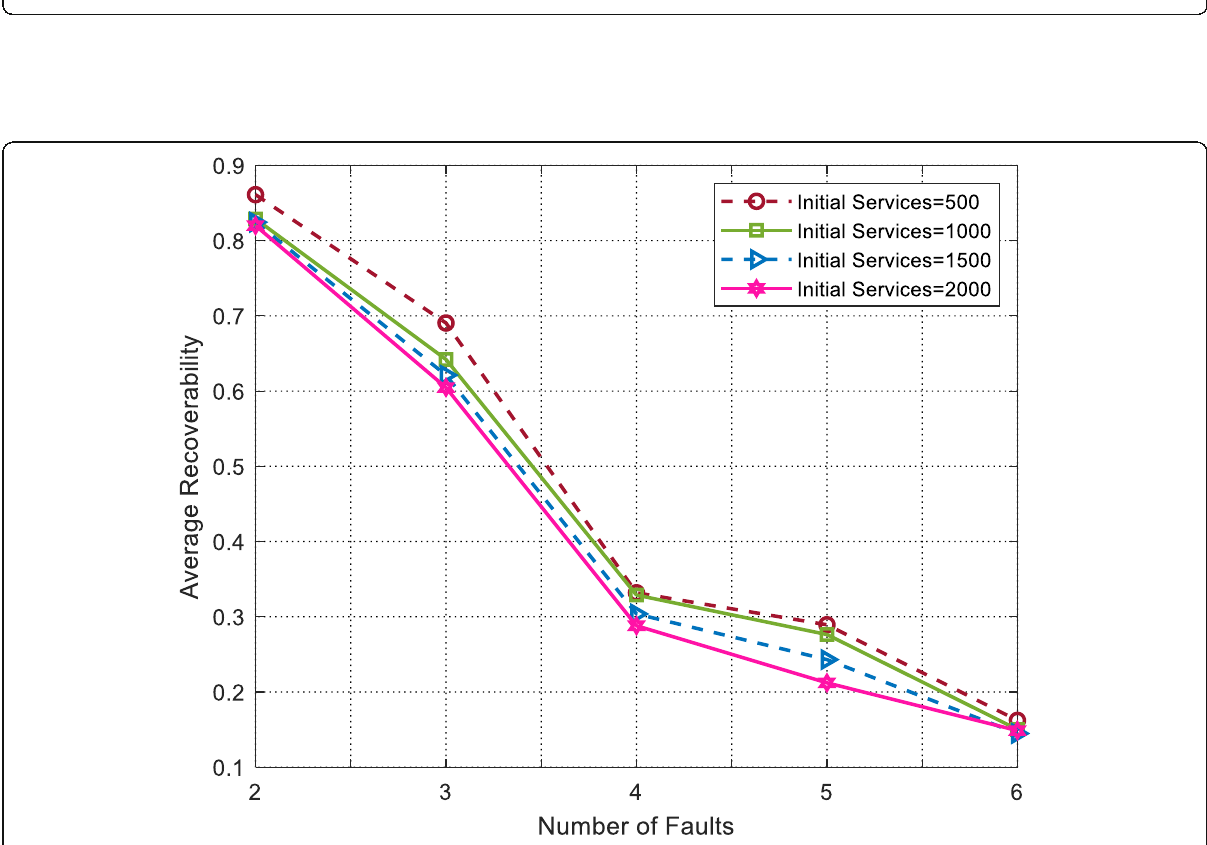
Fig. 9 Average episodes vs. no. of link failures. This figure shows the average episodes as a function of the number of link failures in the case of AS = 15 and AS = 25